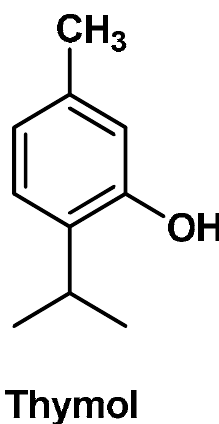
Figure 6. Chemical structure of